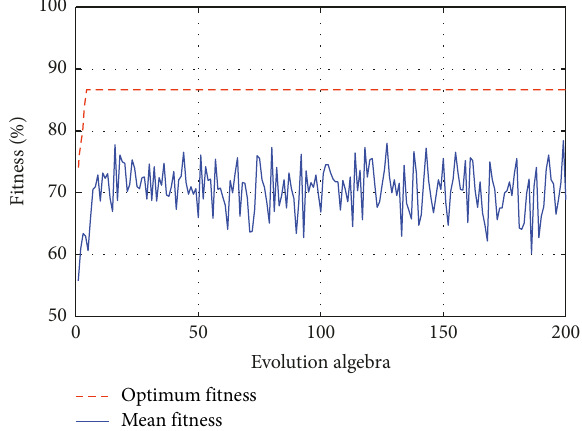
Figure 12: Identification results of Hilbert marginal spectrum as the eigenvalue when noise signal is added into excitation.